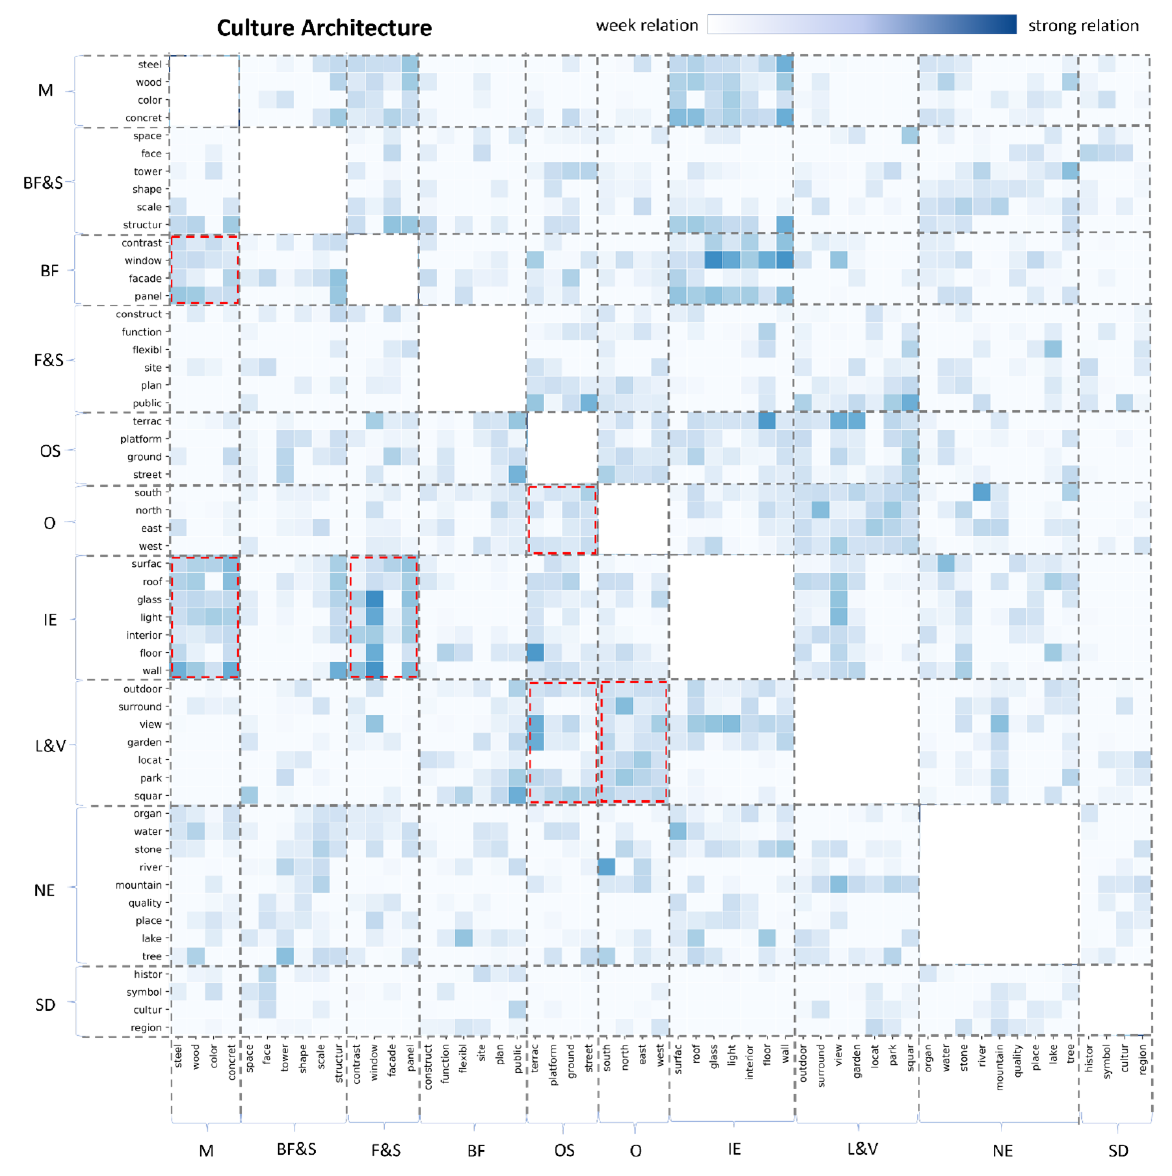
Figure 11. Heat map of clustered words related to culture